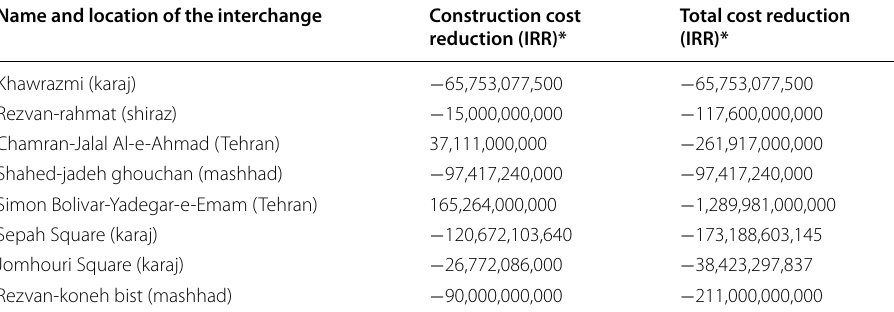
Table 11 The amount of total cost reduction and value study costs of the projects (IRR) Name and location of the